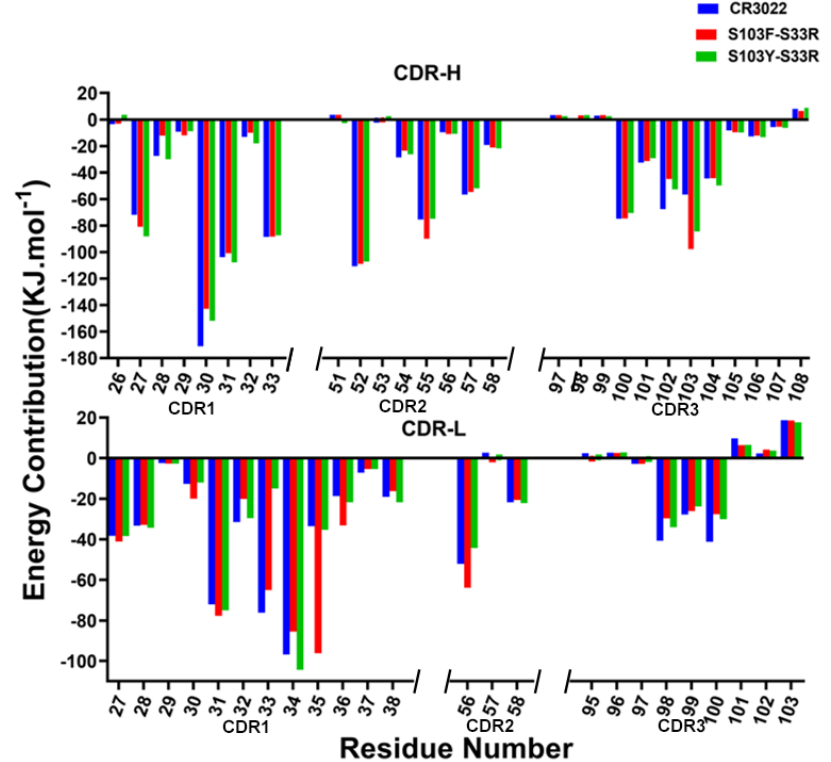
Figure 7. The per-residue binding free energy contributions of different CDRs in the heavy (above) and light (below) chains. The sequence of CDR1, CDR2 and CDR3 with IMGT numbers were separated by a break.